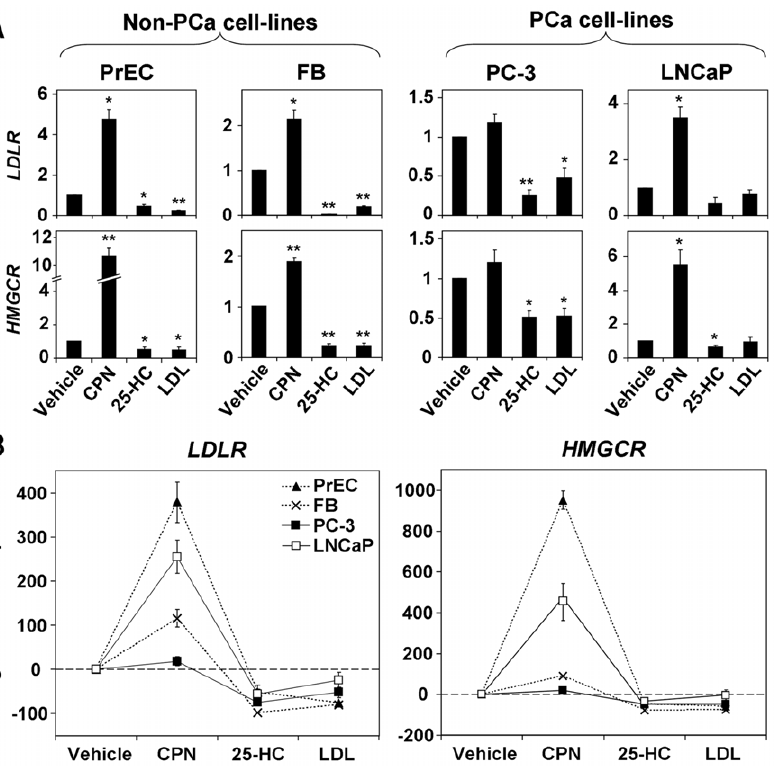
Figure 1. Sterol-mediated regulation of SREBP-2 target genes exists in PCa cells. Cells were treated with the statin compactin (CPN, 5 m M), oxysterol 25-HC (1 m g/ml), or LDL (50 m g/ml) for 24 h. Cellular RNA was harvested and mRNA expression of the LDLR and HMGCR genes was analyzed by qRT-PCR. The mRNA levels were made relative to the vehicle condition as described in Materials and Methods. Data are mean + SEM, from 3 separate experiments for each cell-line. Each experiment was performed with triplicate wells per condition. (A) Data presented separately for each cell-line. * p , 0.05, ** p , 0.01, two-sample t -test versus vehicle condition. (B) Data from (A) has been overlaid for each gene, represented as mean 6 SEM for each datapoint. The PCa cell-lines are represented by solid lines, whilst the non-PCa cell-lines are represented by broken